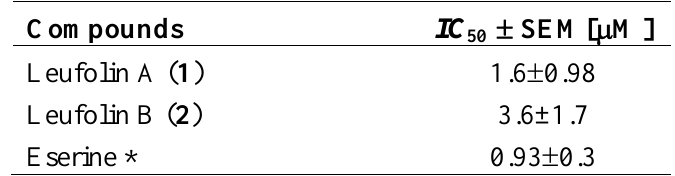
Table 2. Steady-state inhibition of BChE enzyme by compounds 1 and